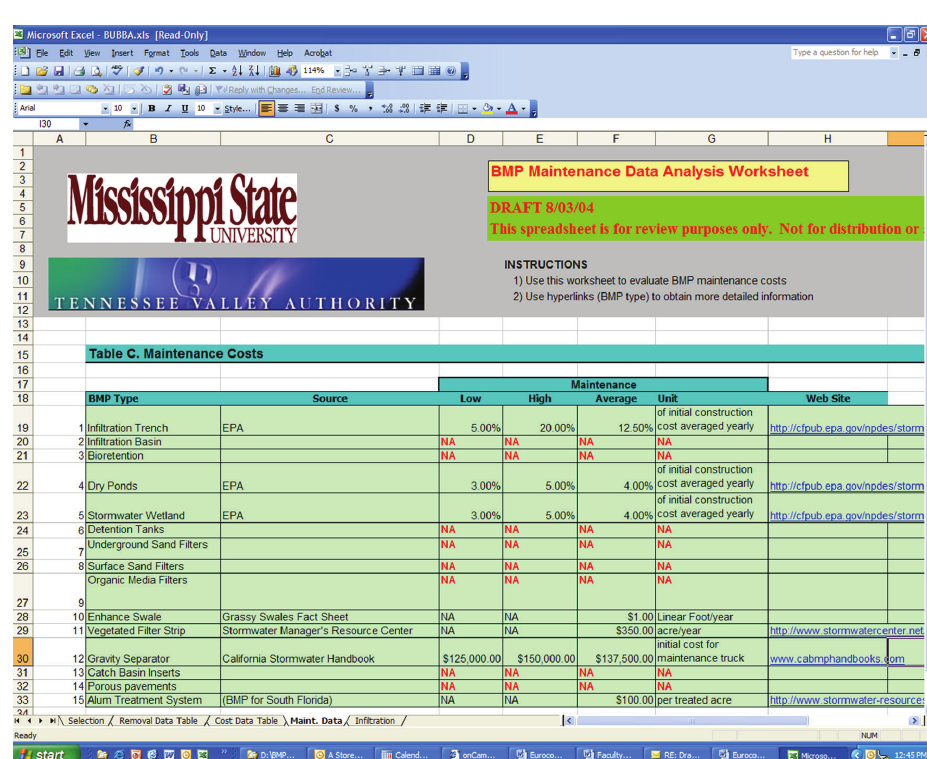
Figure 5: The Maintenance Data Table